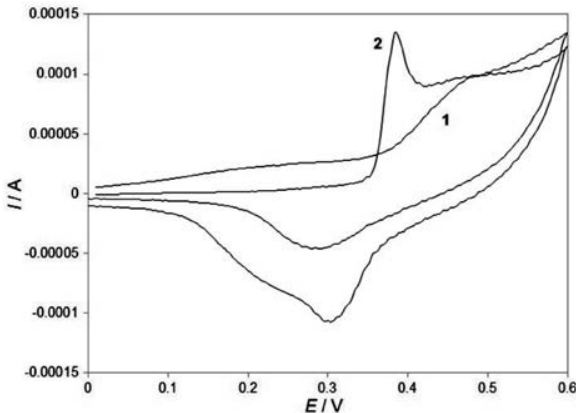
Figure 1. Consecutive cyclic voltammogram of Ni-Cu electrode ox- idation in 1 M NaOH (1) first and (2) fiftieth cycle at a scan rate of 100 mV s –1 .